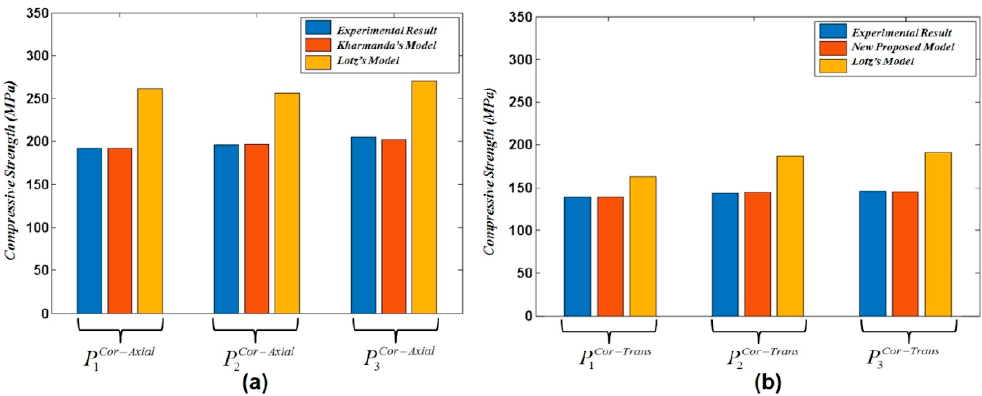
Figure 3. A comparison between experimental compressive stress in cortical bone for ( a ) Lotz’s model (Equation (12)) and Kharmanda’s model (Equation (16)) in the axial direction, and ( b ) Lotz’s model (Equation (13)) and the newly proposed model (Equation (17)) in the transversal direction. Materials 2020 , 13 , x FOR PEER REVIEW Giesen et al. [22] tested the cancellous bone in both directions for several specimens. A